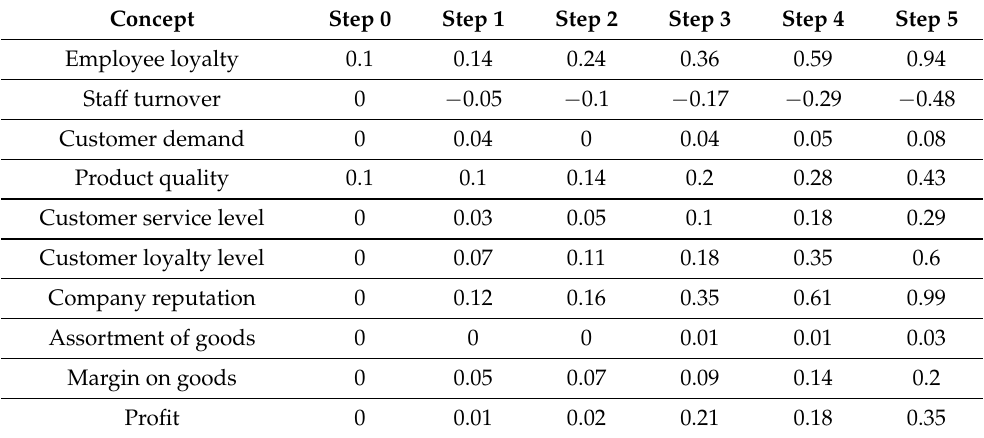
Table 5. Changes in the system concepts over five steps for the scenario of increasing the concepts of “Product quality” (K30) and “Employee loyalty level”